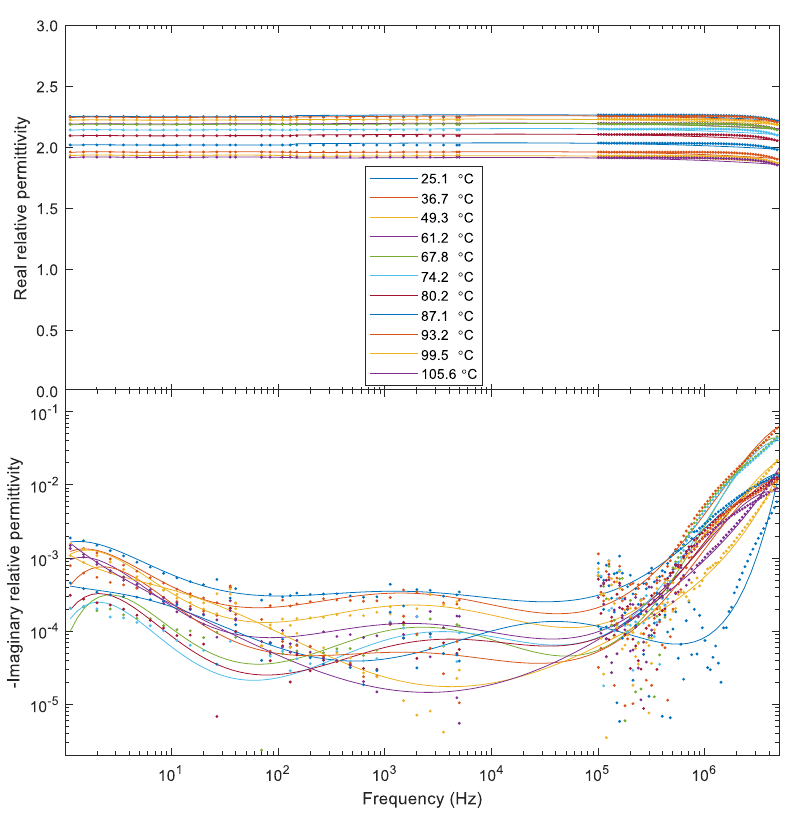
Figure 2. Real and imaginary relative permittivity as function of frequency and temperature; the results up to 5 kHz were obtained with a dielectric material analyzer and the results as from 100 kHz were obtained with a vector network analyzer.